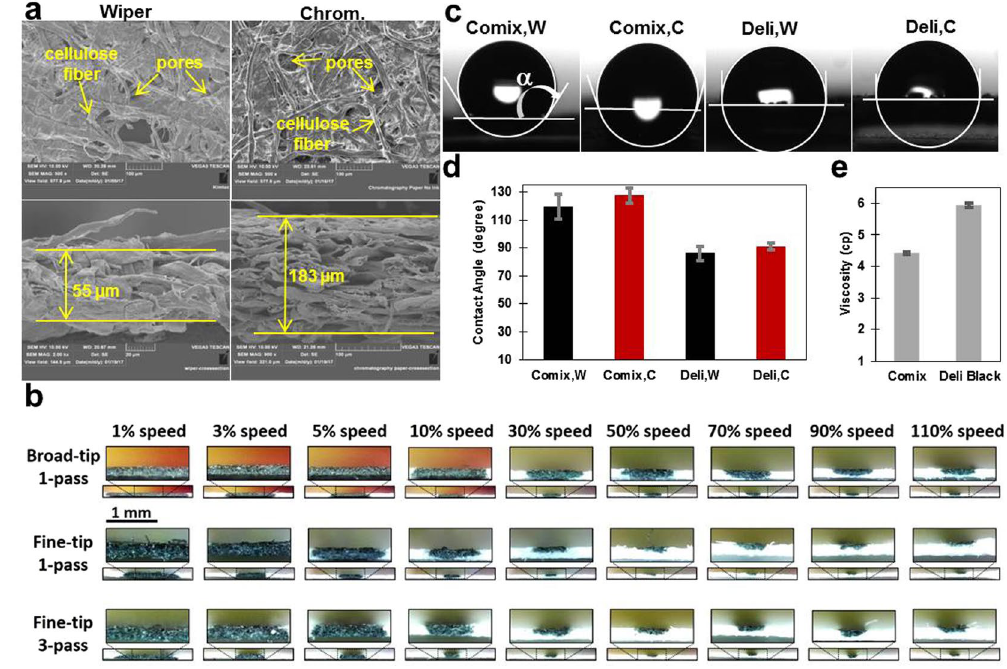
Figure 3. Characterization of paper substrates and inks. ( a ) SEM images of the surface and cross-section of delicate task wipers and chromatography paper. ( b ) Diffusing ink through chromatography paper at different plotting speeds from 1% (5.45 mm/s) to 110% (177 mm/s), and number of passes using fine and broad-tip of Comix marker. ( c ) Images of a 2- µ l-droplet on different substrates covered with the inks. C and W stands for chromatography paper and Wipers, respectively. ( d ) Contact angle of a 2- µ l-droplet on substrates covered with Comix and Deli ink (data are average of left and right contact angles). C and W stands for chromatography paper and Wipers, respectively. ( e ) Viscosity of Comix and Deli inks at 23 °C. Measurements are average of six repeats for both contact angle and